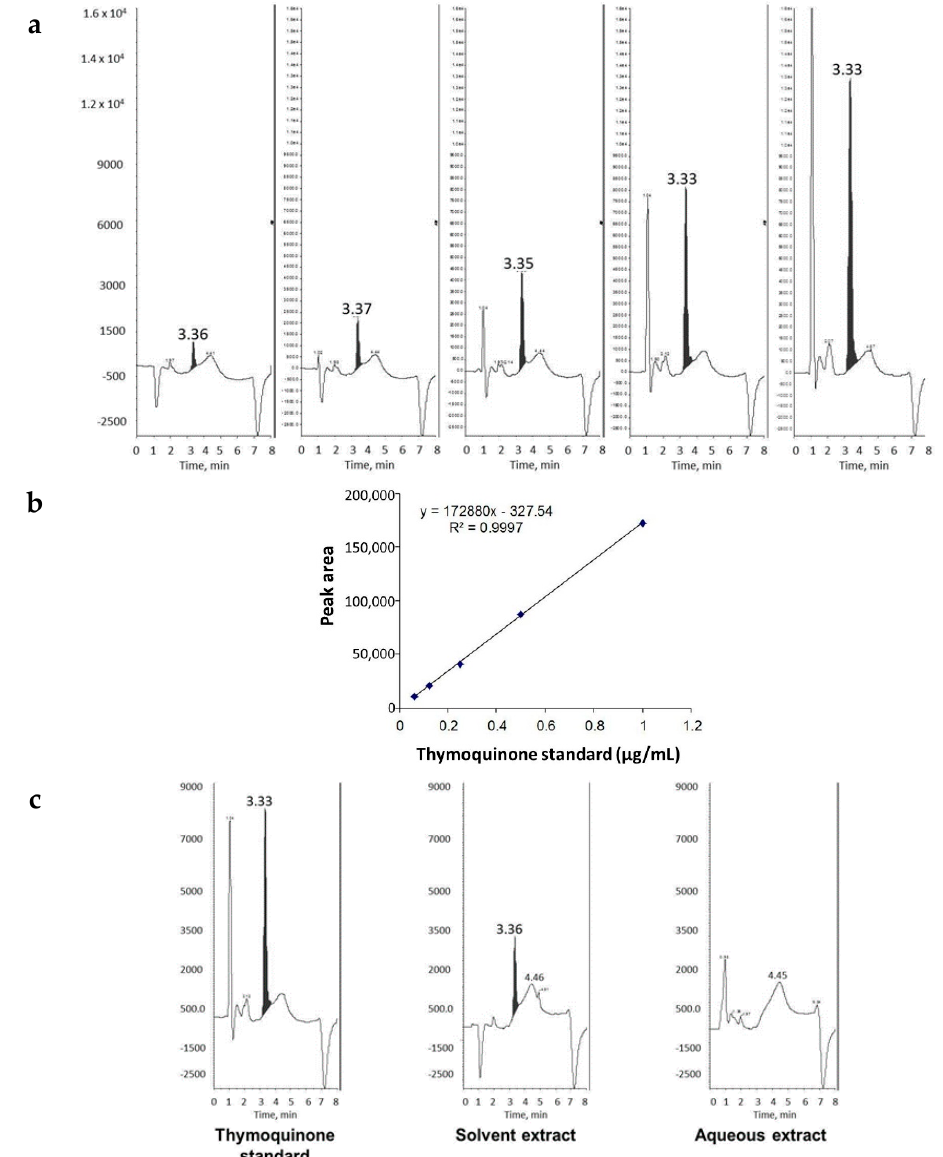
Figure 1. Detection and quantitation of THQ extracted from black seeds. ( a ) HPLC analysis of pure THQ standards in increasing concentrations (left to right); ( b ) calibration curve for pure THQ. The graph shows good linearity, indicating the power of THQ detection and quantitation by HPLC analysis; and ( c ) HPLC detection of THQ in solvent extract and aqueous extract of black seeds in comparison to THQ standard. Note the absence of THQ in aqueous extract.